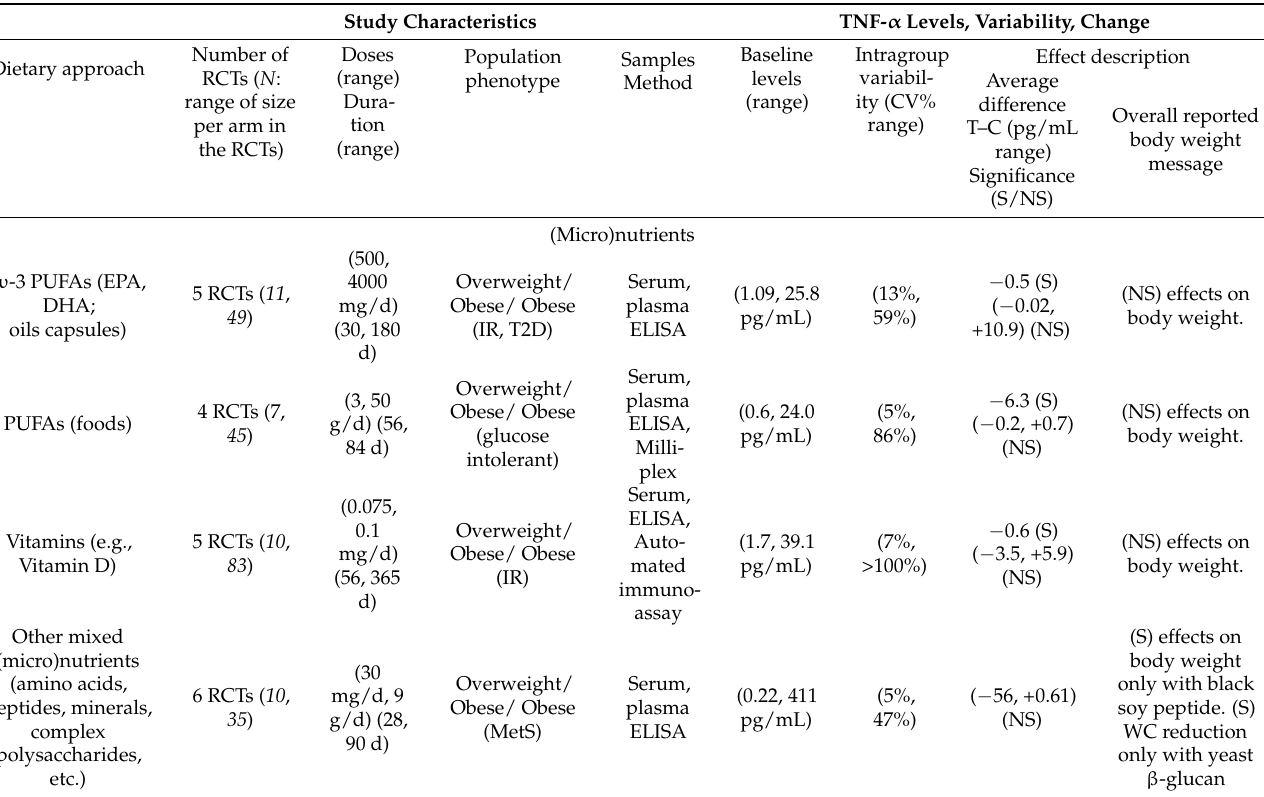
Table 2. Summary of the results from the human intervention studies gathered in this review looking at the effects of different dietary products and several anti-obesity drugs on the circulatory levels of TNF- α in overweight/obese participants in relationship with body weight